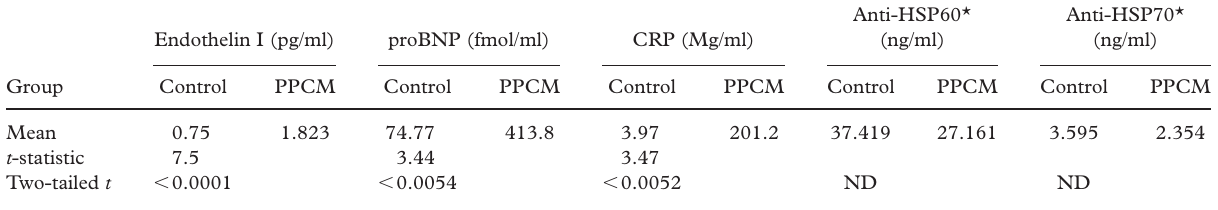
Table II. Biomarkers of inflammation and